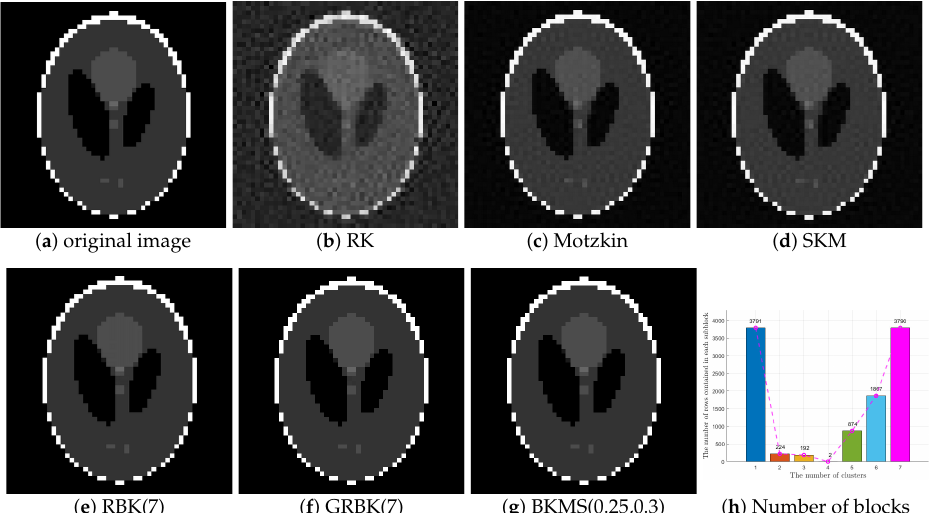
Figure 5. The original " phantom ” image ( a ), the recovered images by RK ( b ), Motzkin ( c ), SKM ( d ), RBK ( e ), GRBK ( f ), and BKMS ( g ). The visualization of row partitions by MS clustering ( h